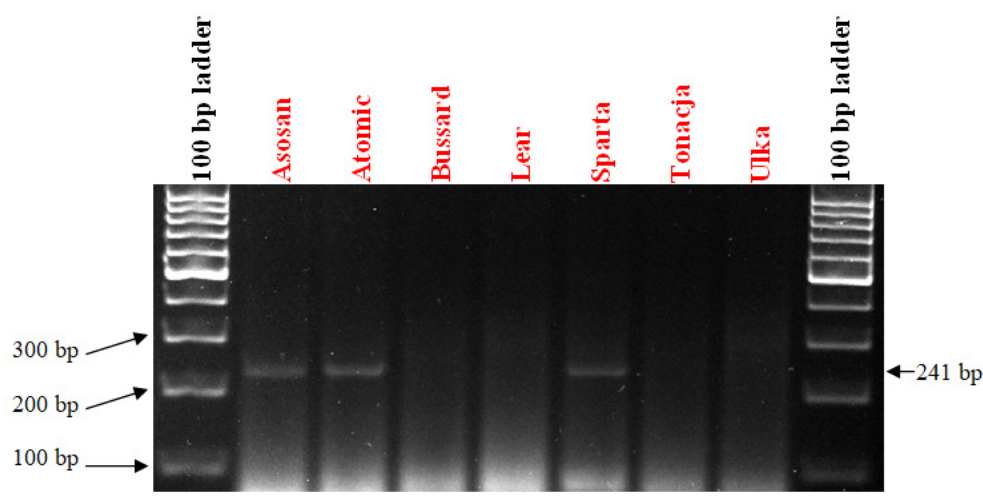
Figure 2: Electropherogram showing the presence of the STS_241 marker of the Pm4b gene in wheat varieties.